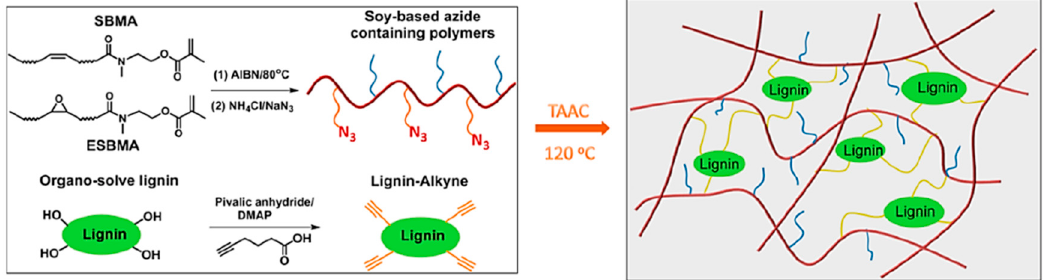
Figure 32. Biobased elastomers prepared by combining soy-based azide-containing polymers and lignin-alkyne. Reproduced with permission [105].